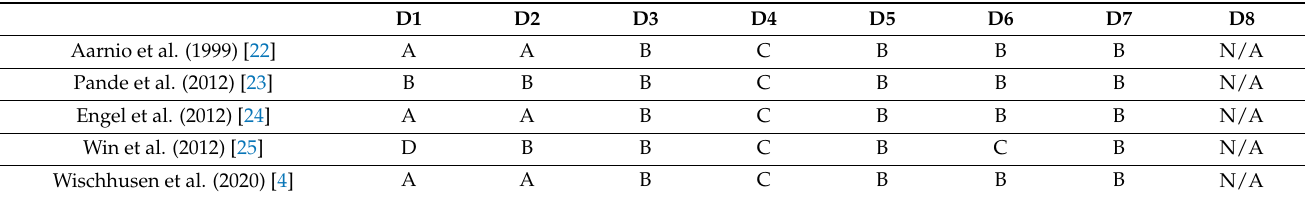
Table 3. Risk of bias analysis using the Cochrane risk of bias tool for cohort